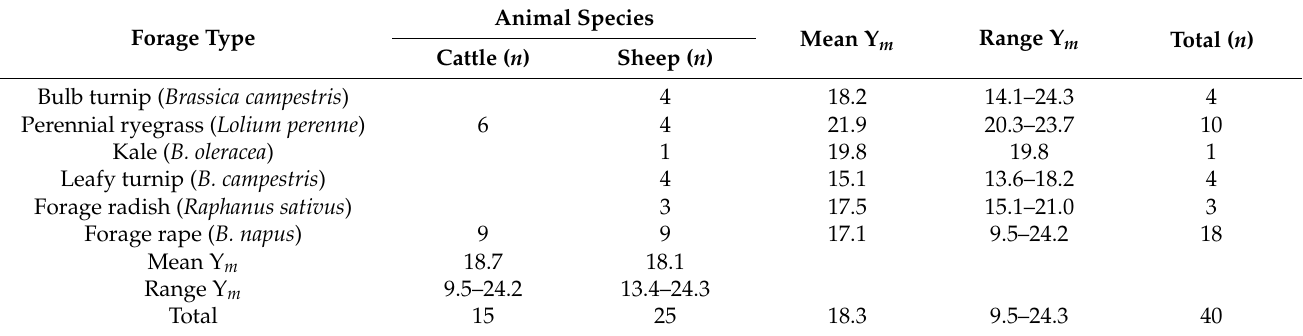
Table 1. Description of the database DB1, showing forage type and animal